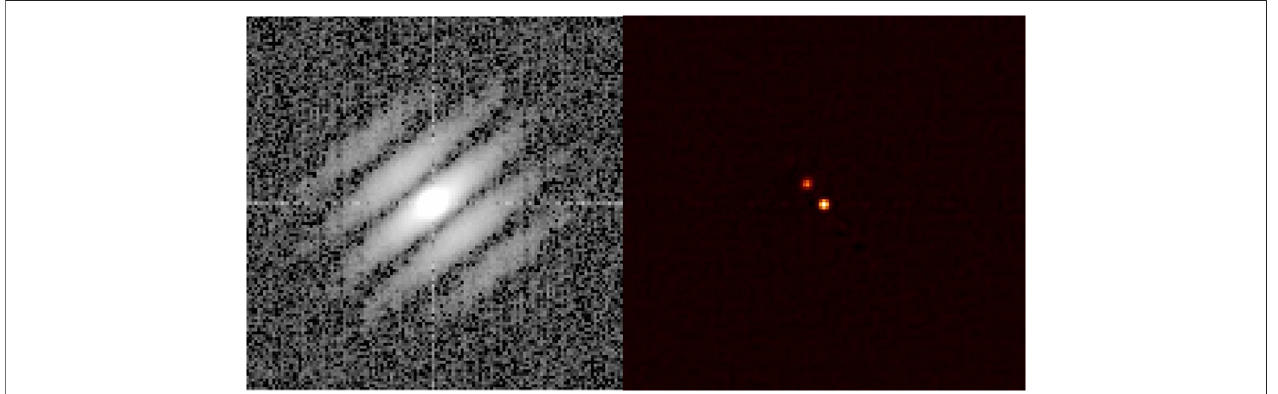
FIGURE 6 | Power spectrum of TOI-1356, an exoplanet hosting star, produced by our reduction pipeline using 2000 speckle images and obtained at the WIYN telescope. Note the interference fringes whose spacing, intensity, and orientation allow a reconstructed image (right) to be produced. From this image and the Fourier analysis, we can determine the separation, position angle, and magnitude difference of the two stars. In this case, the host star is a member of a close binary having a separation near 0.16 arcsec. The reconstructed image is 2 arcsec on a side.